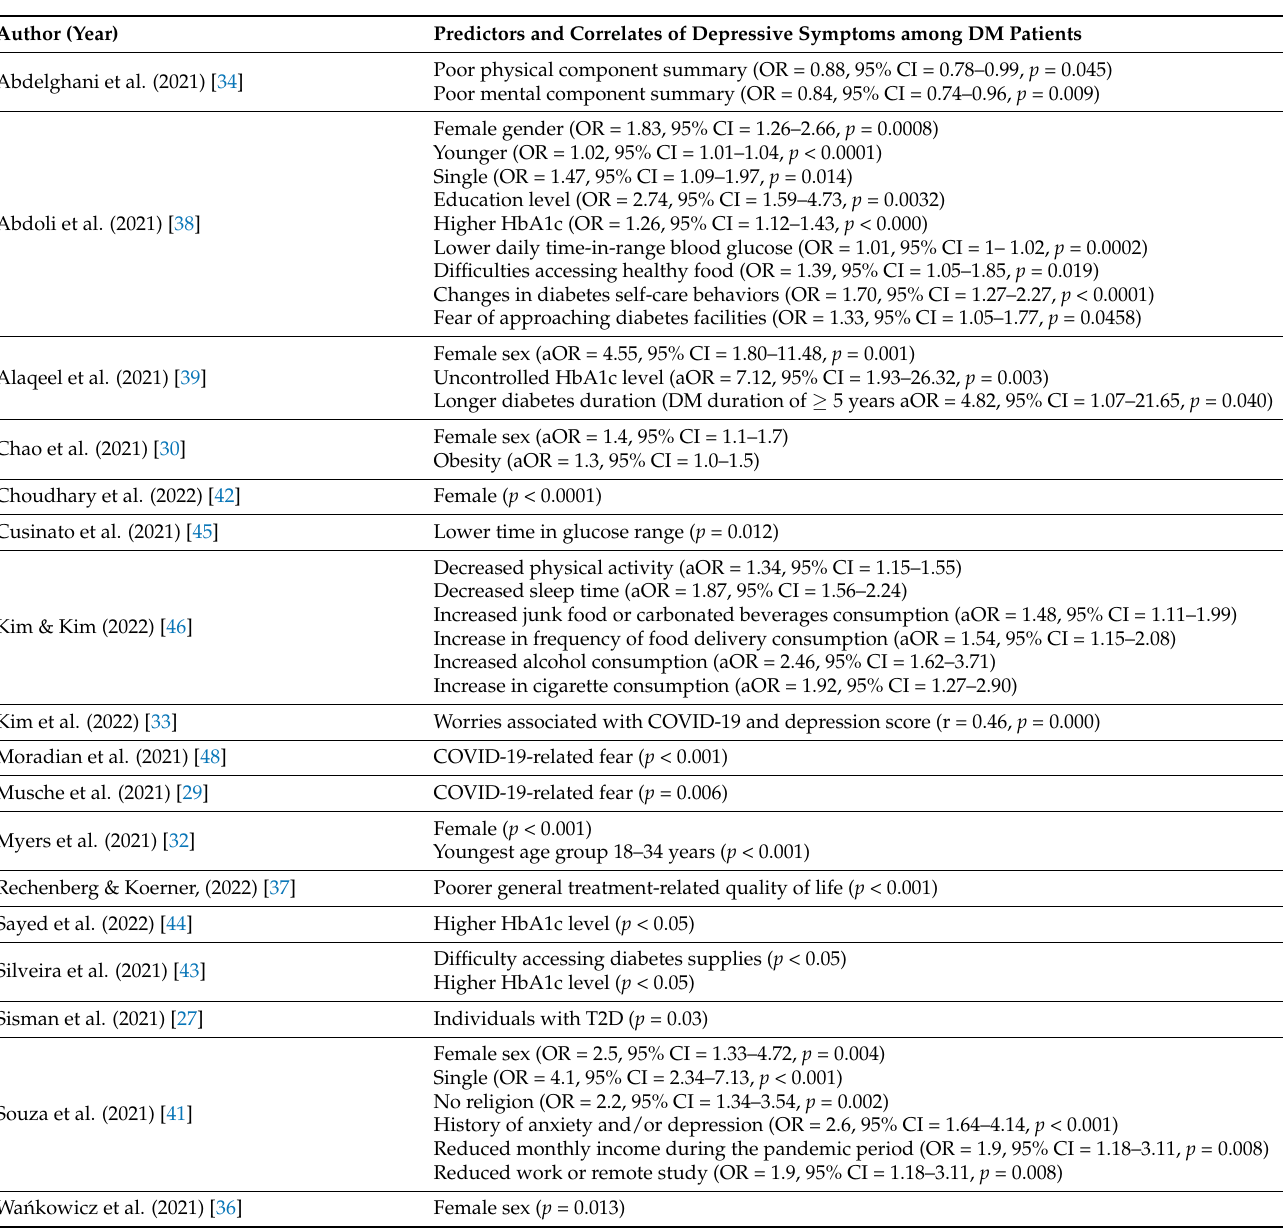
Table 2. Main predictors of depressive symptoms and their correlations with chronic